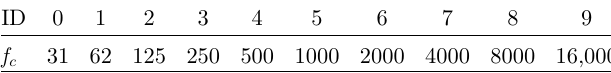
Table 2. Frequency limits in Hz of analysis